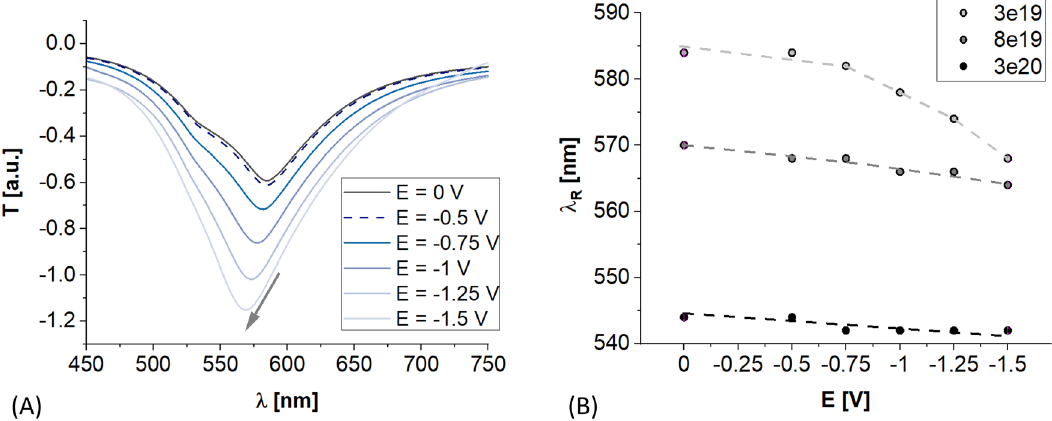
Figure 4: (A) E -induced evolution of ITO-LMR spectral response when charge carrier density reaches 3e19 cm − 3 and (B) LMR wavelength shift with E when N ranges from 3e19 cm − 3 to 3e20 cm − 3 .